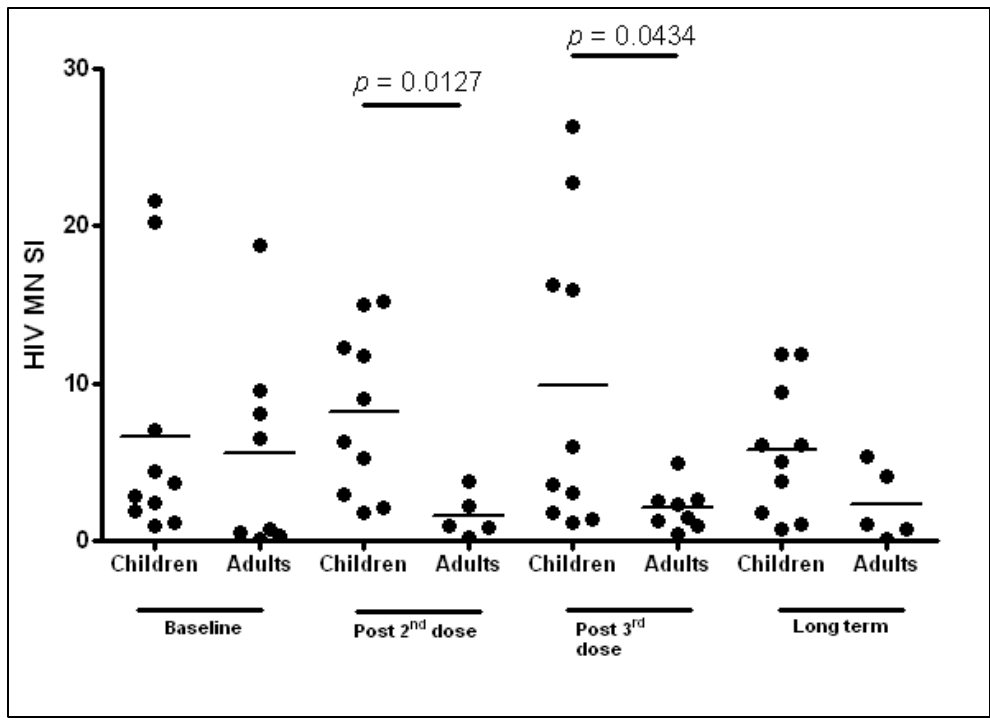
Figure 2. Comparative HIV-1 MN antigen lymphoproliferation for paediatric and adult cohorts. SI, stimulation